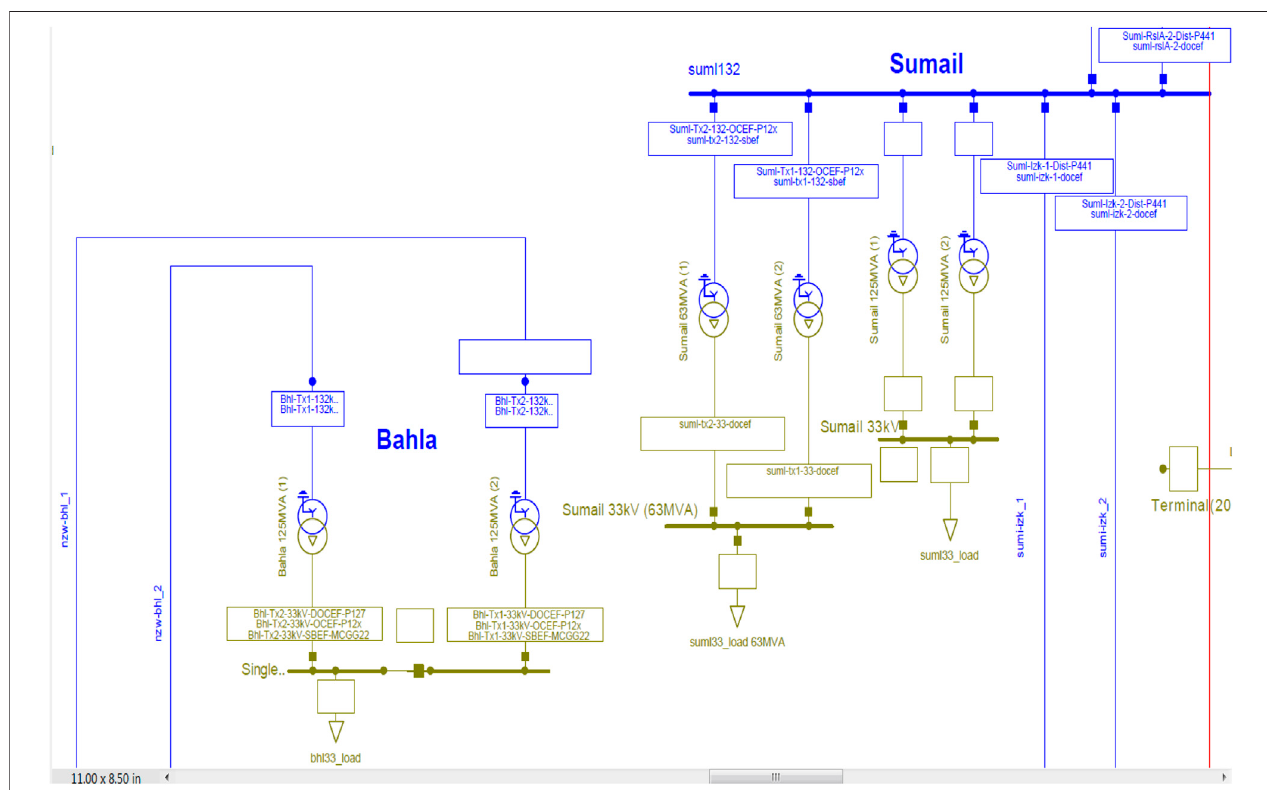
FIGURE 10 | Bahla and Sumail transmission protection